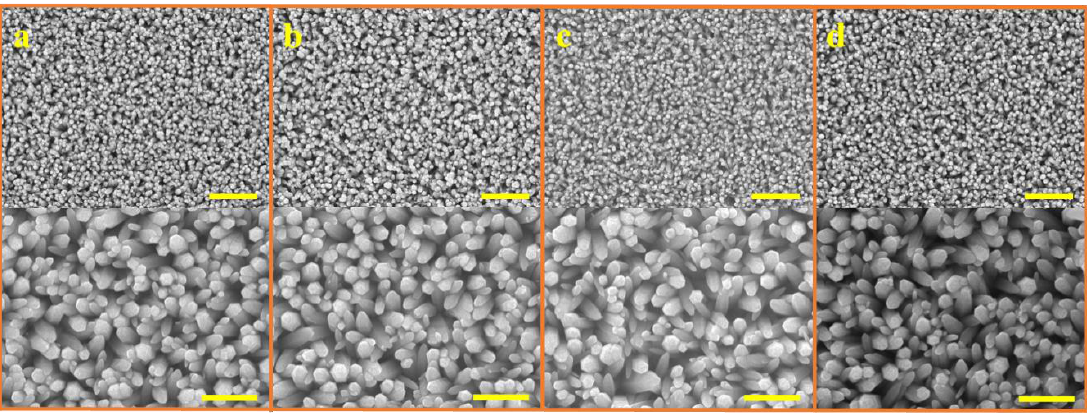
Figure 2. SEM images of ZNRs grown with ( a ) ACG, ( b ) Ga-doped ACG, ( c ) OPT-ACG, and ( d ) MAG methods. The scale bars in the top and bottom images correspond to 3 and 1 microns, respectively.